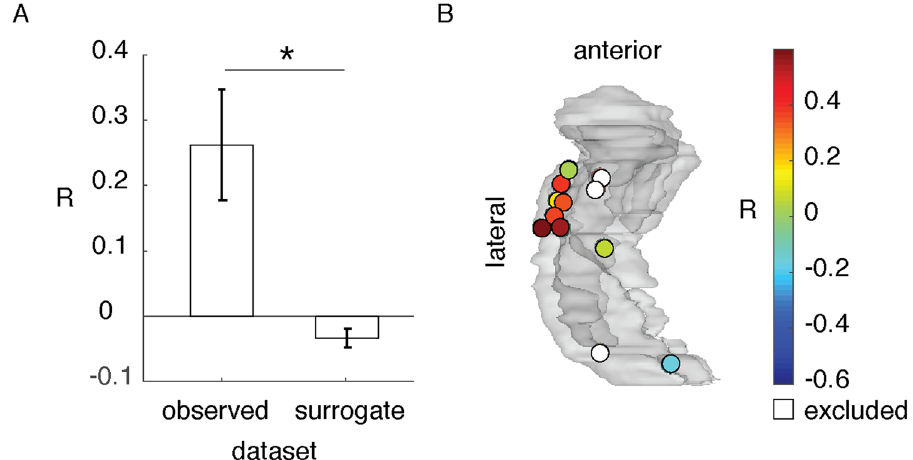
Figure 4. Similarity-distance and semantic distance correlation coefficient (R) (A) comparing the data with a surrogate permutation shows that the similarity-distance between HFB pattern during the pre-picture interval of an expected picture and other picture intervals correlated with the semantic distance of the expected picture concept and the other picture concepts ( * P < 0.05). (B) shows the value and topography of observed R (left bar in A ) in a glass hippocampus (see Fig. 2B). The white contacts were excluded from this post-hoc